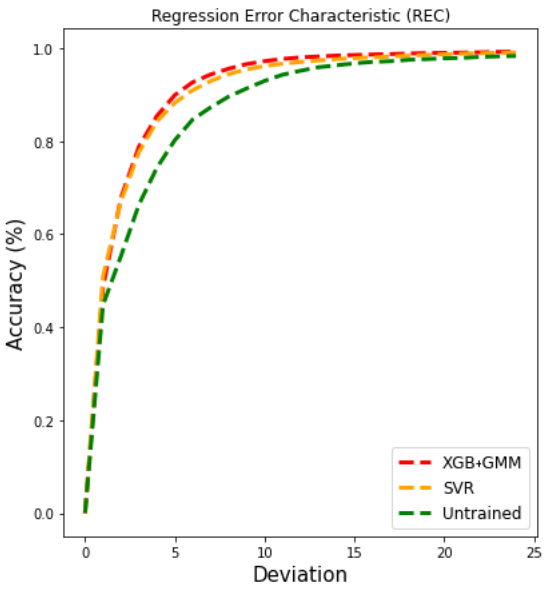
Figure 10. Residual plots and R 2 values for XGB+GMM versus untrained predictor ( left ), and best SVR model versus the untrained ( right ).